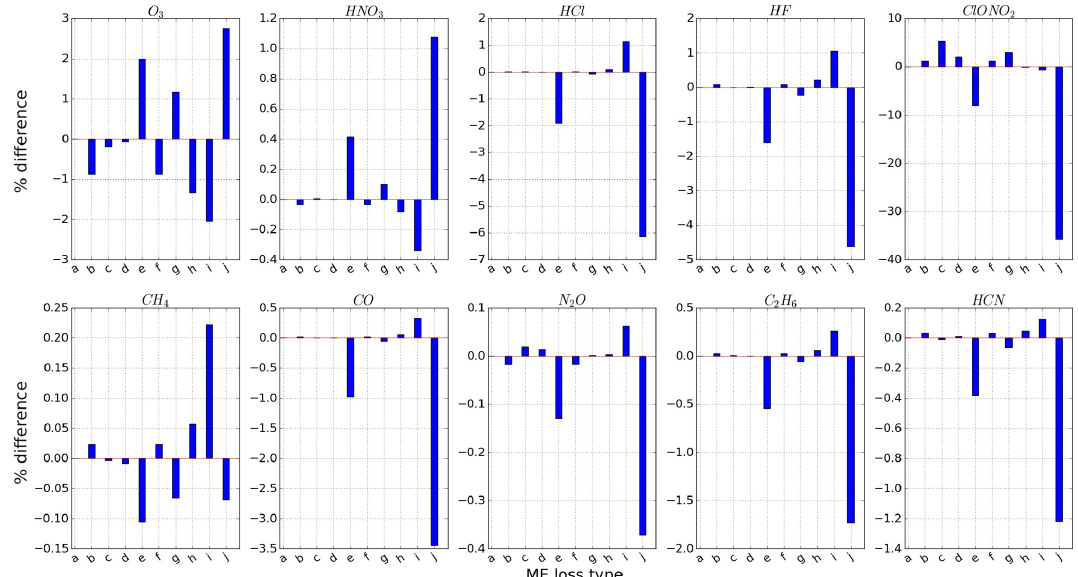
Figure 8. Sensitivity of the total column to different types of ILS degradation. The ILSs a to j correspond to misalignment a to j in Table 1. The results are deduced from the spectra recorded at Hefei on 16 February 2016.